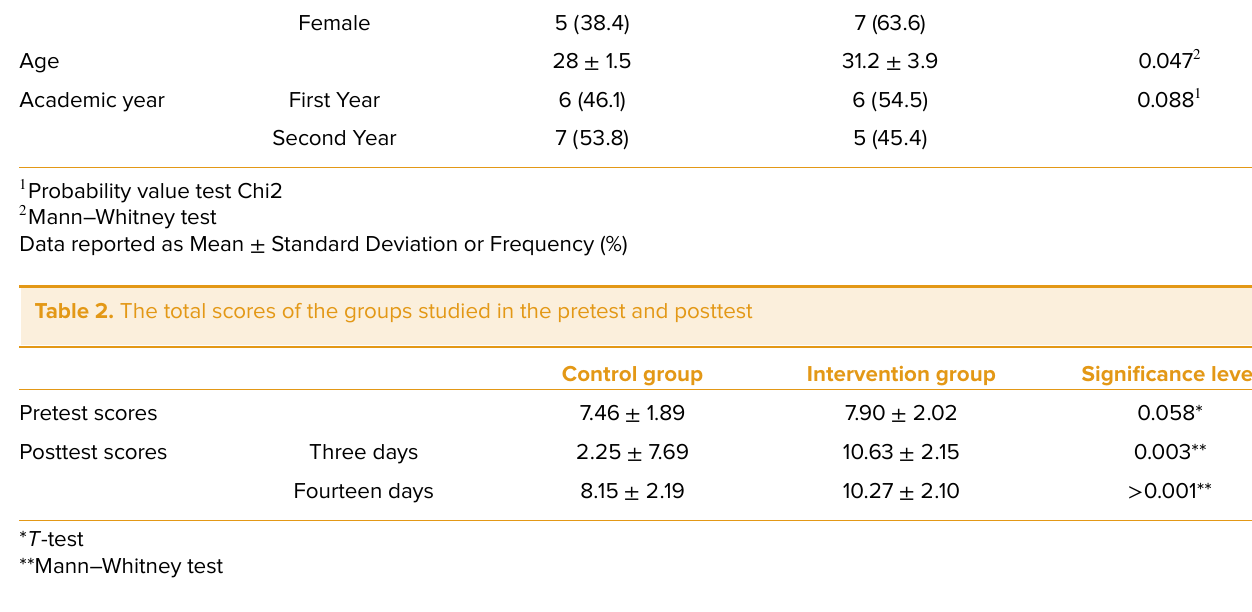
Table 1. Basic characteristics of the studied groups